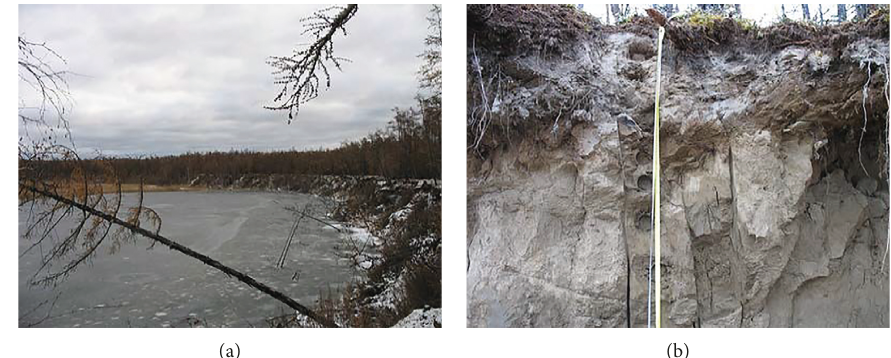
Figure 2: The general view of the thermokarst lake (a), formed as a result of the melting of the ice complex on the monitoring range “Chyuya”; a soil section of Cryosols Haplic Cambisols Dystric of the investigated ice complex